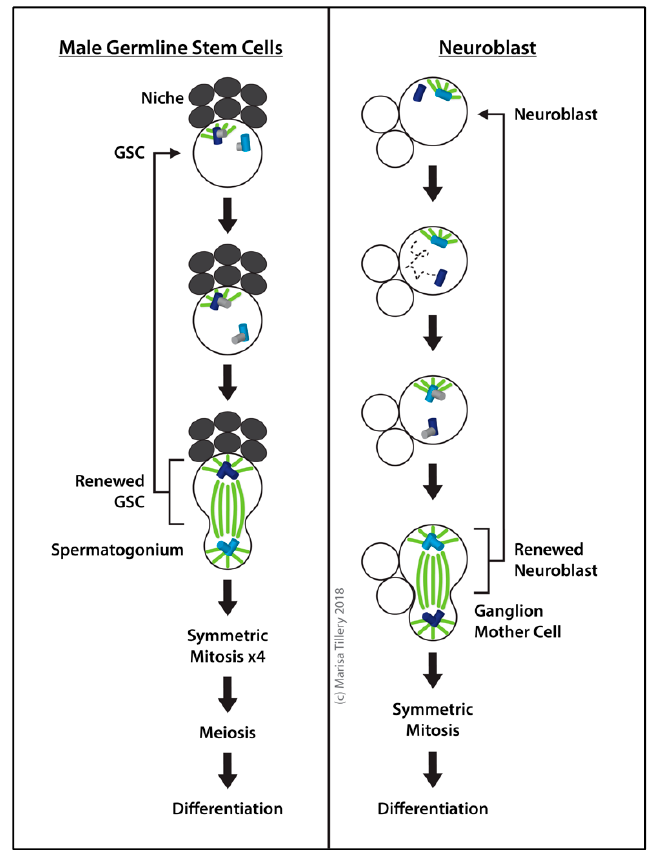
Figure 6. Male germline stem cells (GSCs) and neuroblasts exhibit centrosome asymmetry. Male germline stem cells retain the older mother centriole, which anchors at the apical membrane. Neuroblasts, on the other hand, anchor the daughter centrosome at the apical cell membrane. The neuroblast daughter centrosome maintains active MTOC activity during interphase, while the mother loses it until mitosis. Hub cells in the niche are dark grey; procentrioles are grey; centrioles with MTOC activity are blue: the daughter centrosome is light blue, the mother centrosome is dark blue.